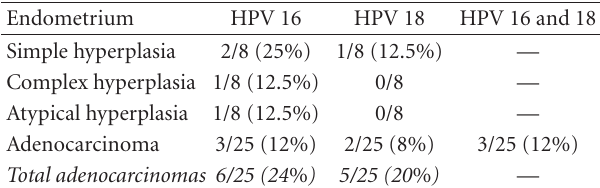
Table 1: HPV detection in hyperplastic and neoplastic en-